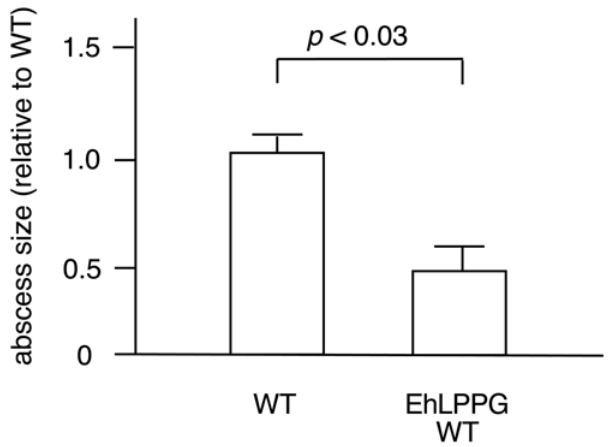
Figure 8. Development of ALA in EhLPPG treated mice. 24 h prior to intrahepatic challenge with virulent E. histolytica trophozoites, WT mice were treated with 4 m g EhLPPG by i.p. application. Seven days post infection, mice were sacrificed and sizes of abscesses were determined. Shown are sizes of ALA in EhLPPG treated mice relative to untreated controls. Results were obtained from 2 independent experiments comprising 5 to 6 animals each (statistics: Mann-Whitney U